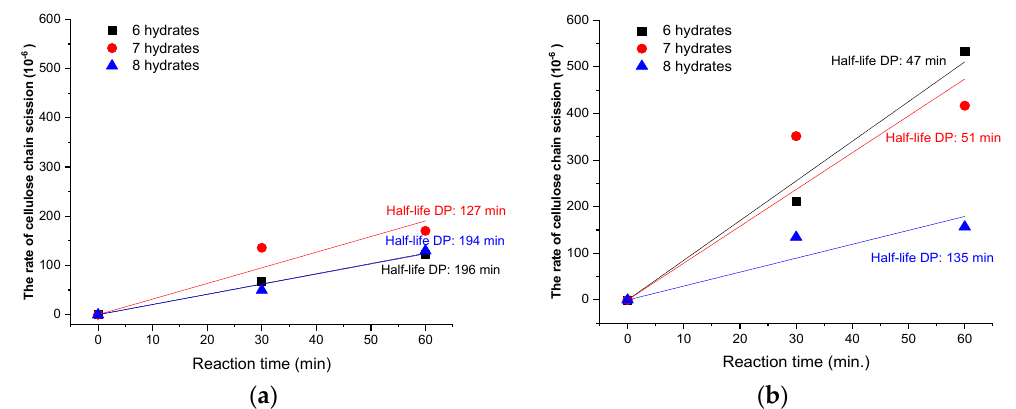
Figure 4. Rate of cellulose chain scission as a function of the number of hydrates in calcium thiocyanate at 100 °C ( a ) and 120 °C ( b ).